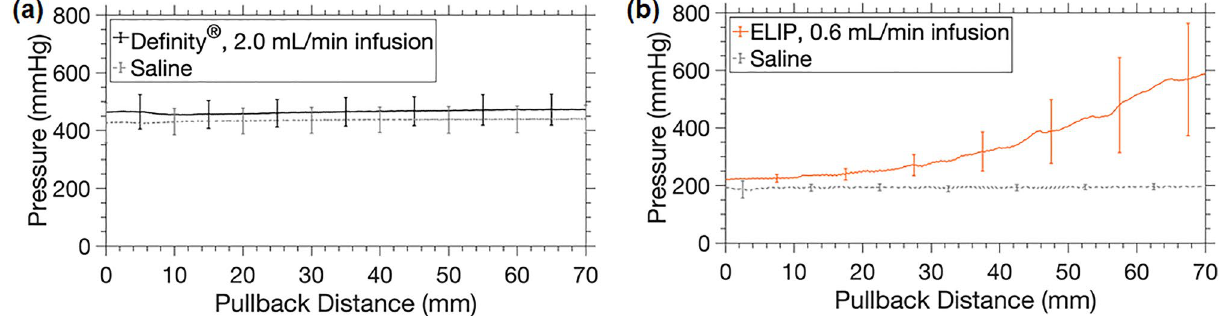
Figure 7. Hydrodynamic pressure within the EkoSonic catheter drug delivery lumen as ( a ) Definity microspheres or saline was infused at 2.0 mL/min or ( b ) OFP-PAFb-PGN-ELIP or saline was infused 0.6 mL/ min, respectively. Error bars represent ± standard deviation, n = 12